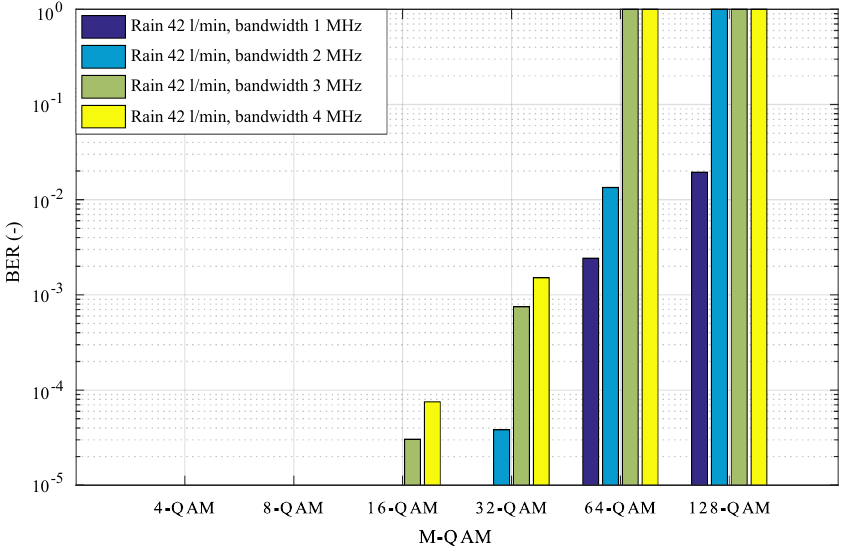
Figure 24. BER/distance relationship for Octavia tail-light with different M-QAM and bandwidths—scenario 3—Rain 42